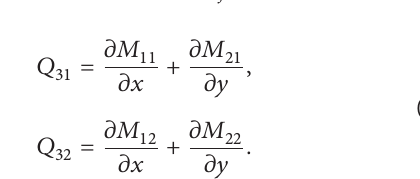
The shear force-bending moment 𝑀 𝑖𝑗 (𝑖, 𝑗 = 1, 2)